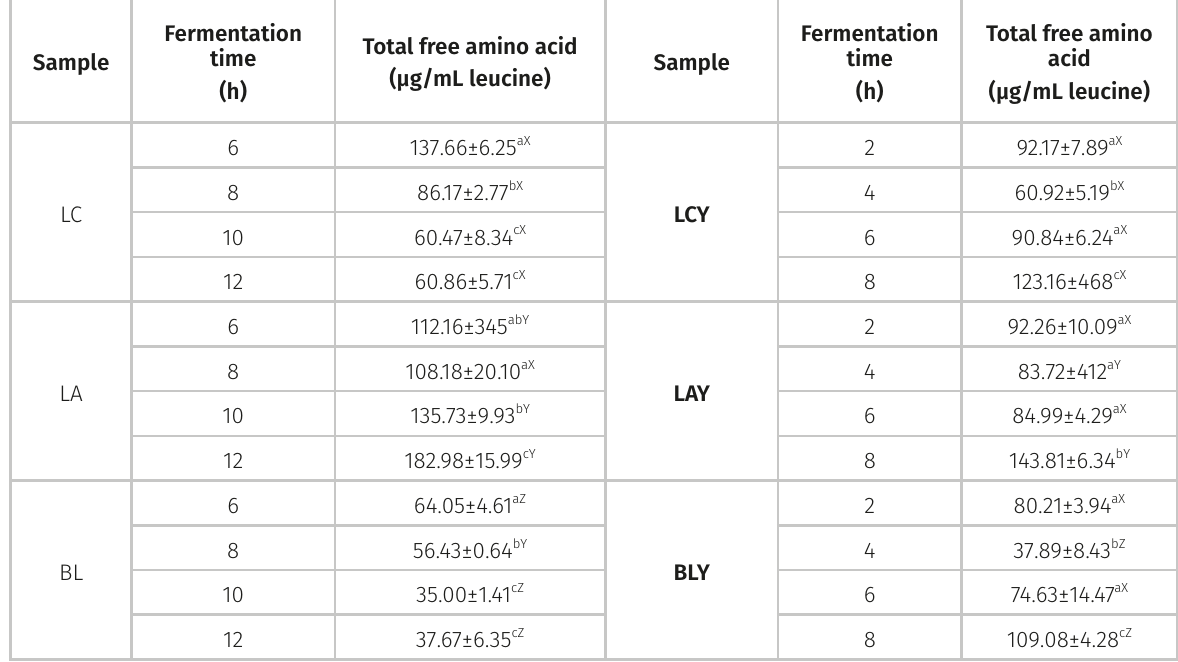
Table V. Total free amino acid contents of all yogurt samples during the fermentation time.